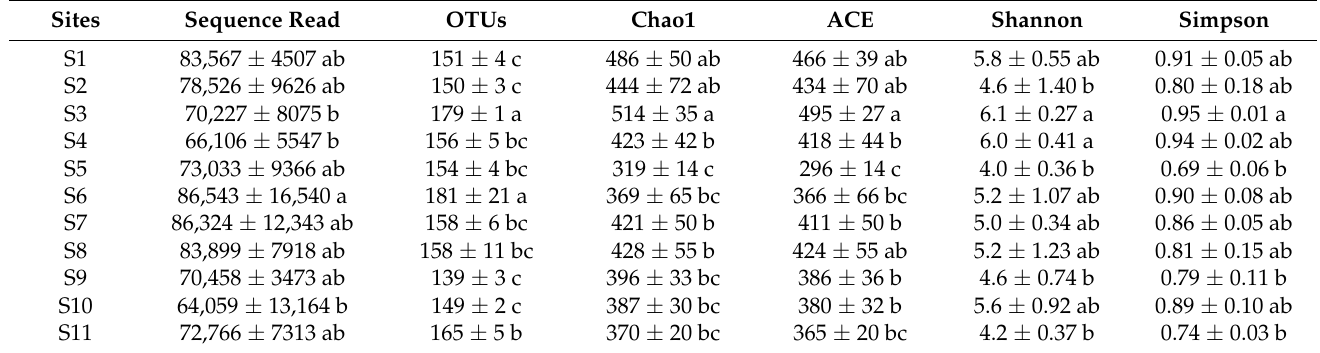
Table 1. Comparison of fungal sequences, the operational taxonomic unit (OTU) richness, and diversity indices of the ITS sequences for clustering at 97% similarity from the sequencing